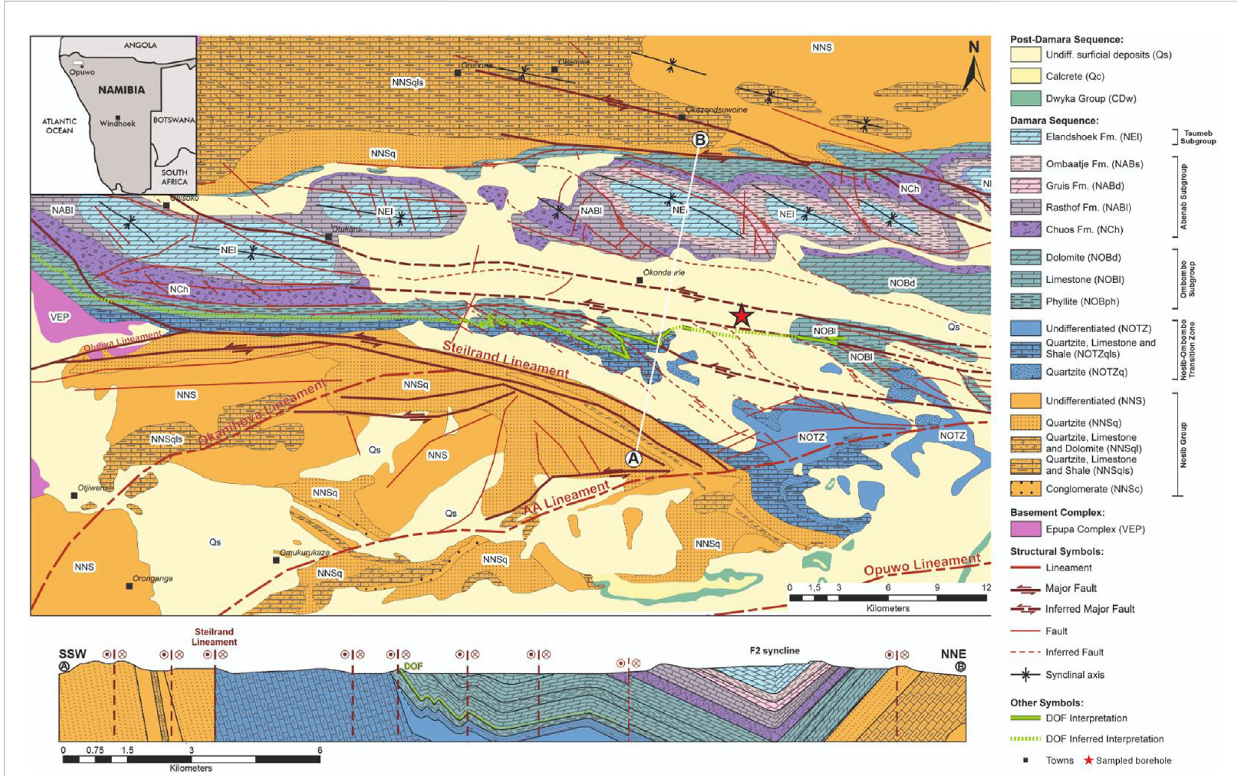
FIGURE 1 Local geological map and schematic geological cross-section (from the A and B symbols on the map) of the Dolostone Ore Formation (DOF) Co- Cu-Zn mineralization (modi fi ed after Bertrandsson Erlandsson et al., 2022; and references therein). The borehole from which the investigated sample is from is marked out with a red